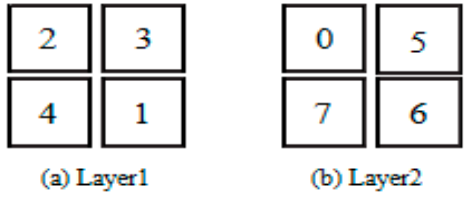
Figure 6. Mapping Figure 6. Mapping results.